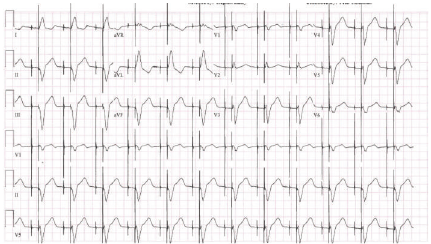
Figure 2: EKG showing AV sequential pacing.